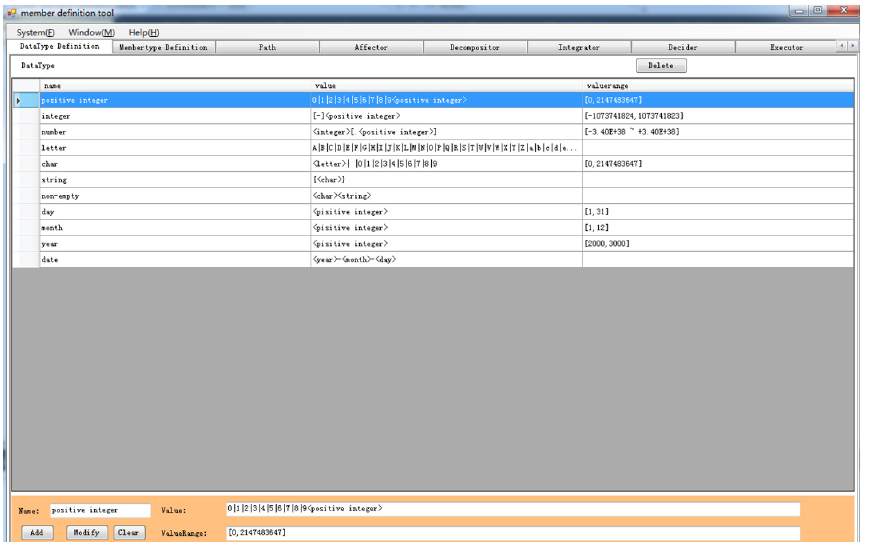
Figure 4. Data de fi